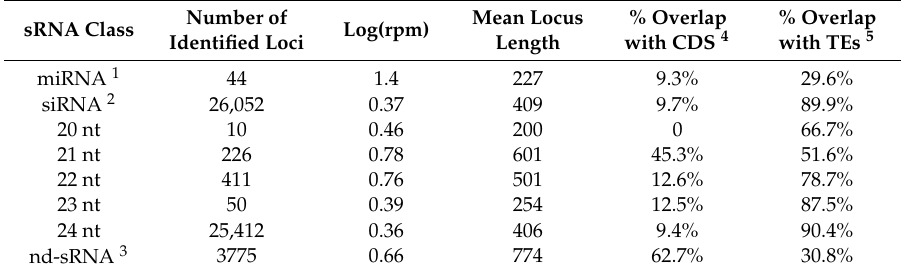
Table 1. Summary statistics of expression and location of sRNA loci.